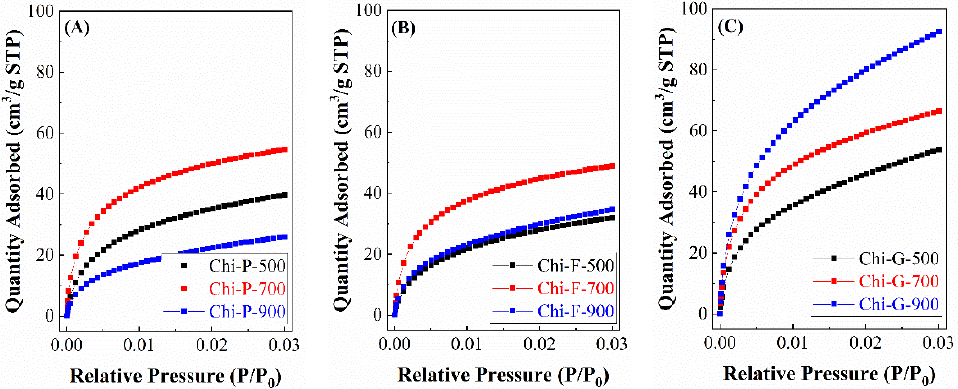
Figure 6. CO 2 adsorption isotherms at 0 ◦ C for the biochars obtained from the chitosans with different morphologies. ( A ) biochars obtained form chitosan directly, ( B ) biochars obtained from chitosan in the form of film and ( C ) biochars obtained from chitosan in globular